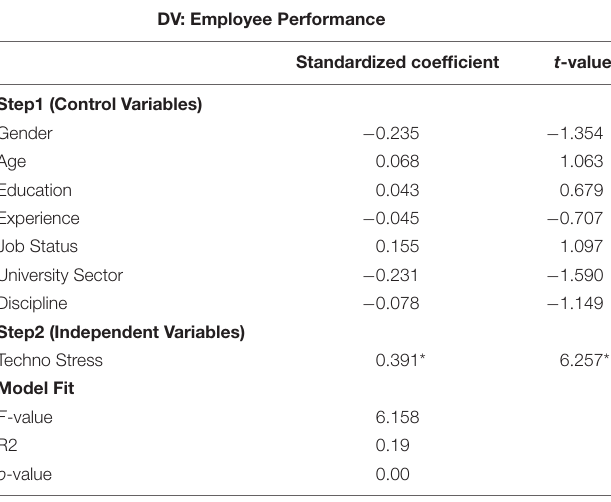
TABLE 4 | Stepwise linear